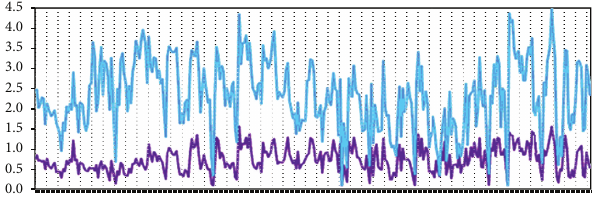
Figure 11: Total electric field strength prediction map of TV 5–12th channel broadcasting